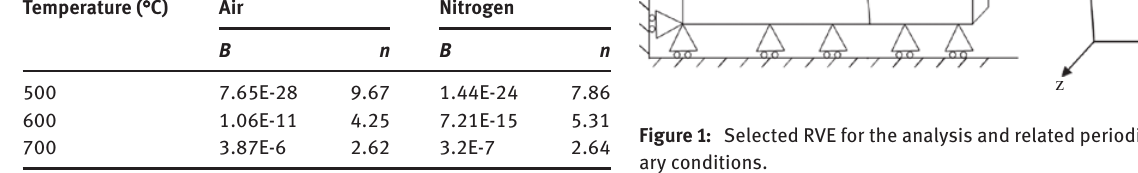
Table 2: Creep parameters of Ti-6Al-4V [37]. Temperature ( ° C)